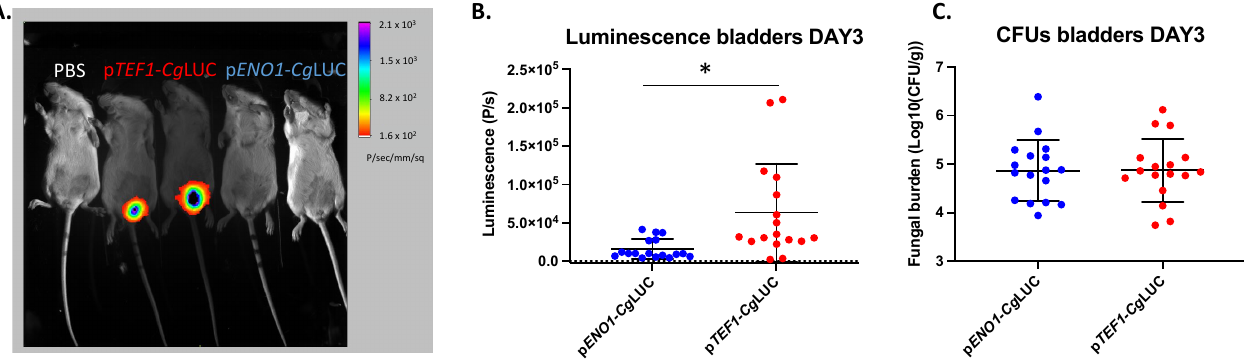
Figure 3. In vivo comparison of two luciferase-expressing constructs in C. glabrata in the bladder. ( A ) BLI of infected bladders with either the p TEF1 - Cg LUC construct or the p ENO1 - Cg LUC construct. ( B ) BLI in the bladder for the two constructs. Seventeen mice for each group were infected with 2.5 × 10 8 C. glabrata cells directly into the bladder. Luminescence in the bladders was measured on day three post infection. A statistically significant, higher luminescence can be observed in mice infected with C. glabrata containing p TEF1 - Cg LUC (unpaired t -test, p = 0.075). ( C ) Fungal burden in the bladders of mice infected with C. glabrata expressing different luminescence constructs. All error bars show standard deviations. Significance: * p < 0.05 ; P/sec/mm/sq: photons per second per mm 2 .